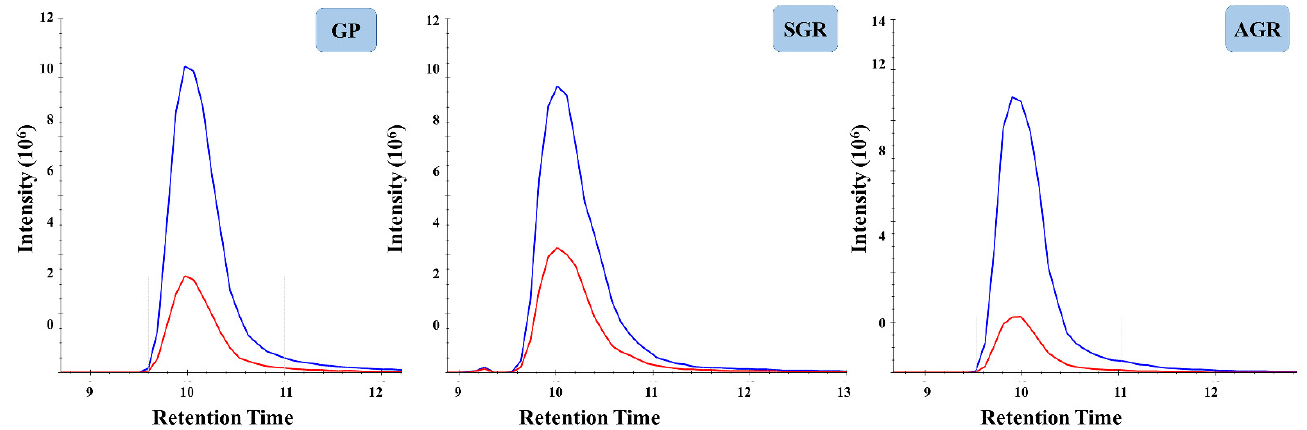
Figure 3. Representative PRM spectra of dermcidin’s ENAGEDPGLAR peptide. The ‘y’ axis shows the intensity of chromatographic peaks while the ‘x’ axis shows the retention time (min). Blue lines refer to the synthetic, SIL peptides, while red lines indicate the endogenous peptides. GP refers to gland poor, SGR represents sebaceous gland rich and AGR the apocrine gland rich healthy skin regions.